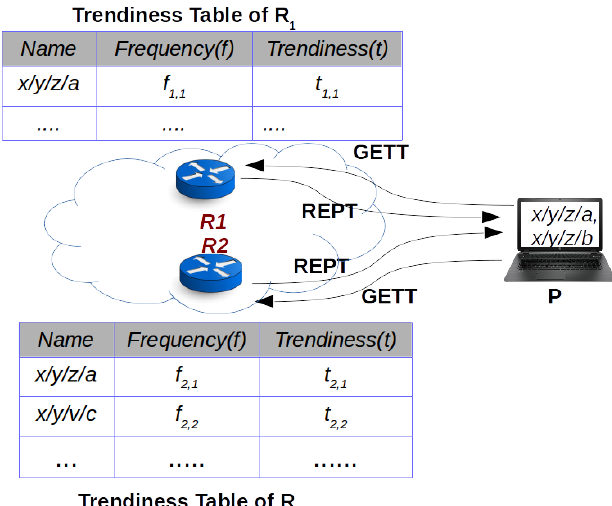
Figure 1. Example scenario for producer